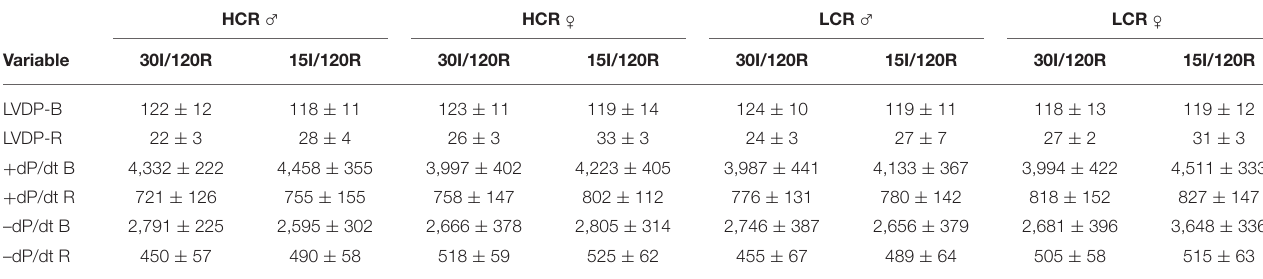
TABLE 1 | Summary of functional variables in global ischemia groups, by Phenotype, Sex, and duration of global